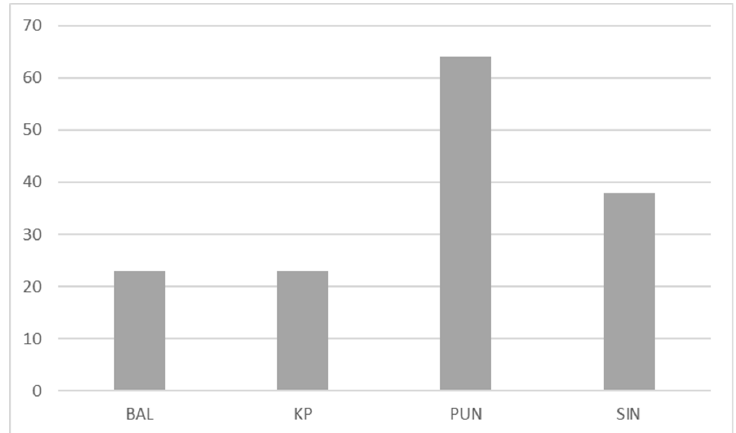
Figure 17. Terrorism intensity statistic (TIS) values for Balouchistan (BAL), Khyber Pakhtunkhwaa, (KP), Punjab (PUN), and Sindh (SIN), for the time period 1988–2012.